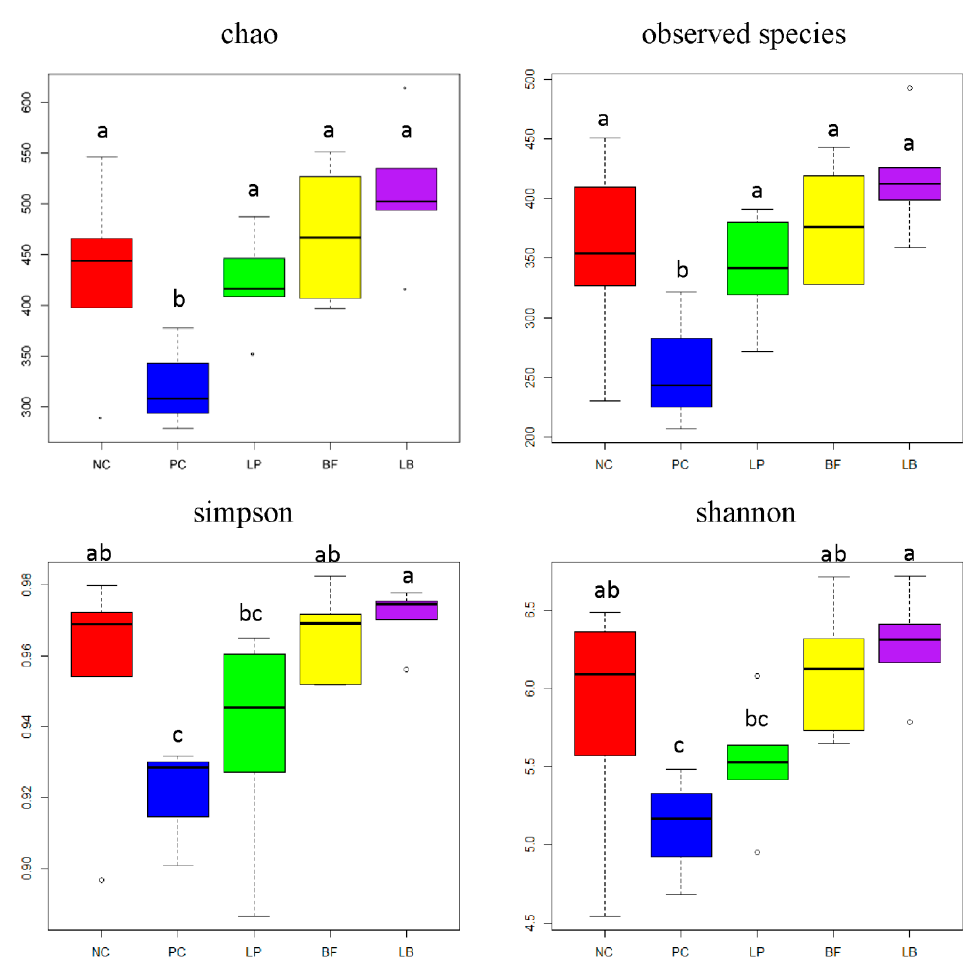
Figure 2. Effects of L. plantarum , tartary buckwheat flavones, and their combination on the community richness estimates and diversity indices of weaned piglets.